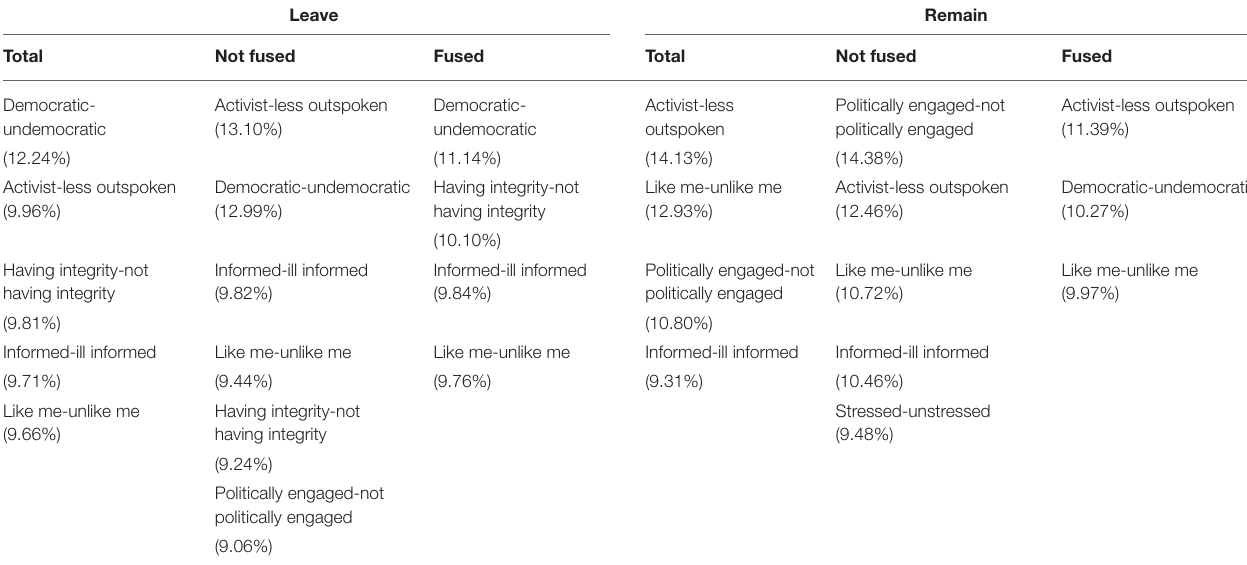
TABLE 4 | Constructs responsible for most discrimination between elements ( >